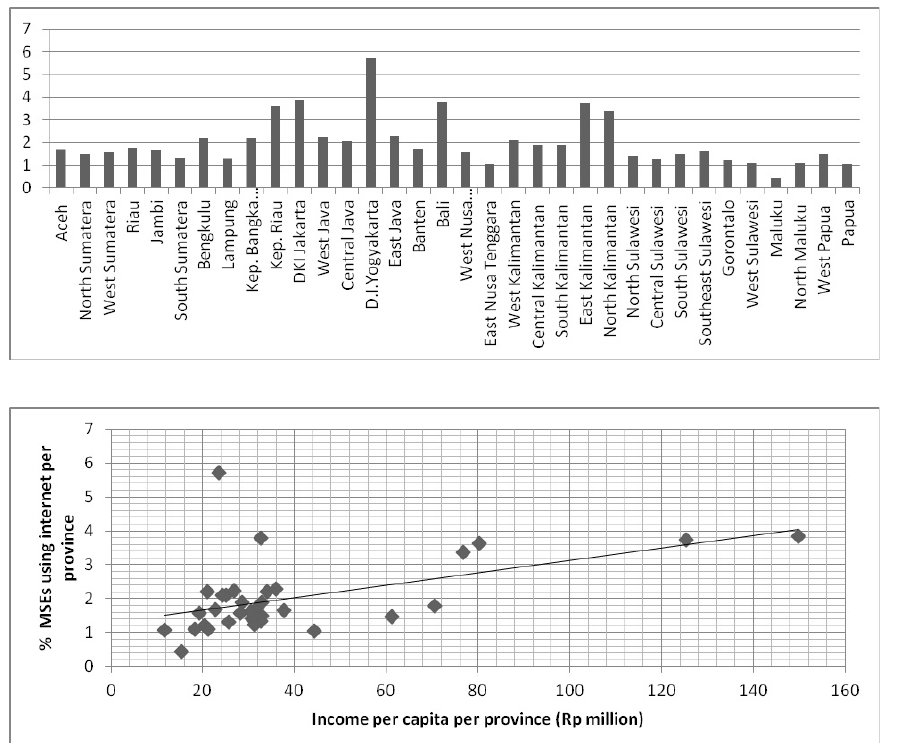
Figure 7. Percentage of MSEs using internet per